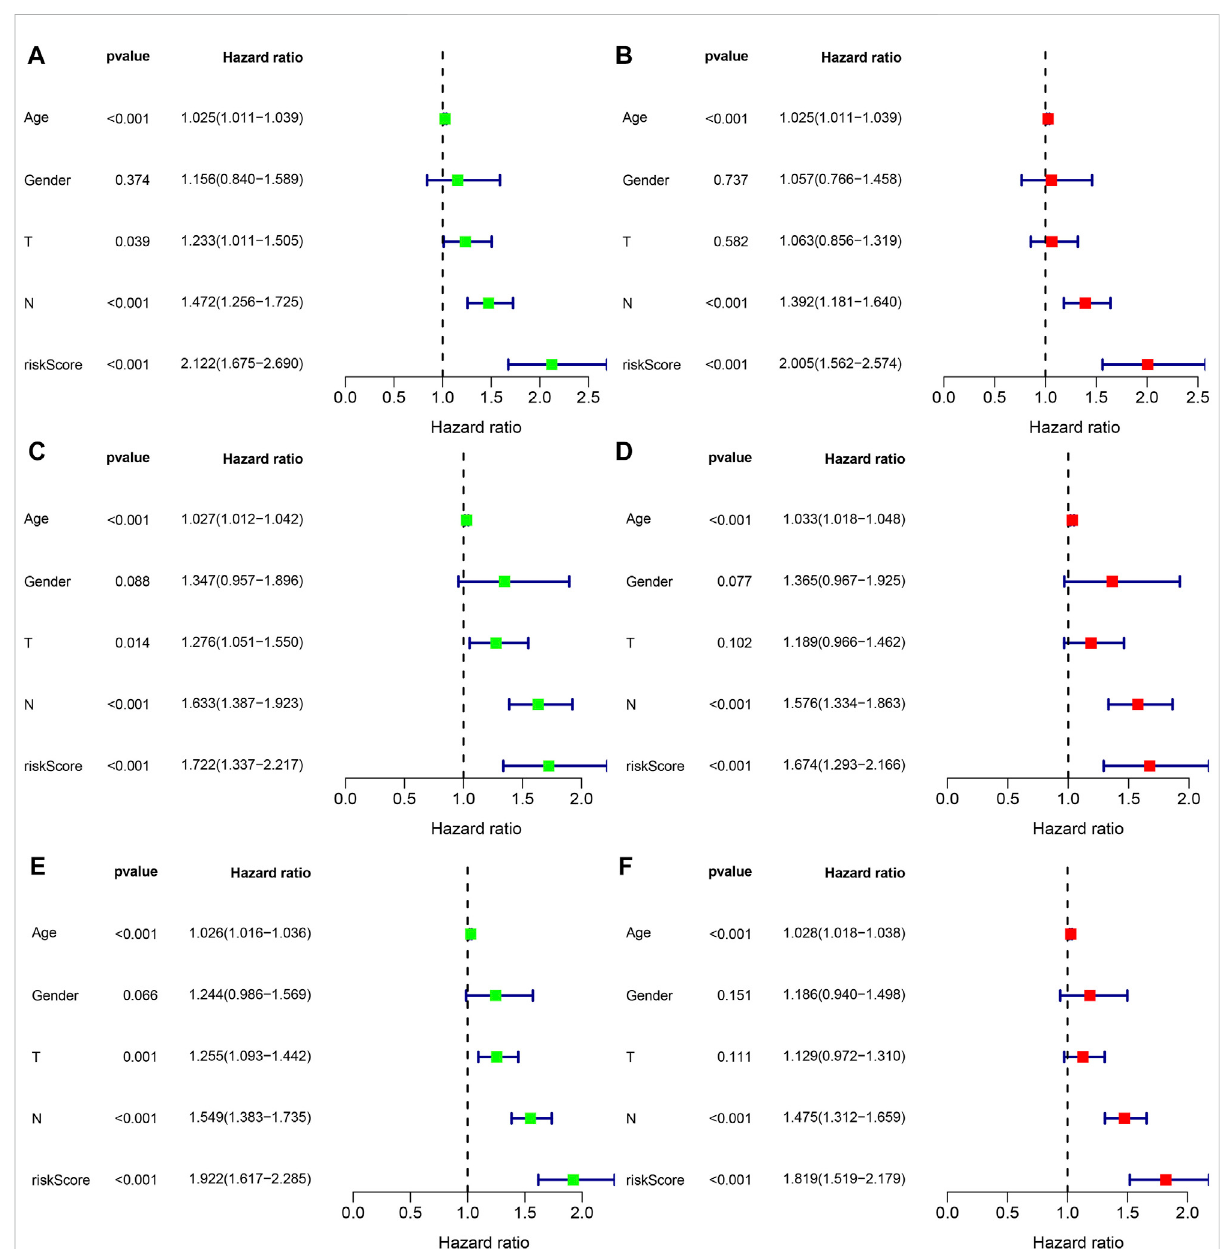
FIGURE 8 The independent prognosis analysis of the risk score and clinicopathological variables in gastric cancer. (A,B) Univariate and multivariate Cox regression analyses of clinicopathological variables and risk scores with OS in the training set, (C,D) testing set, and (E,F) entire set.